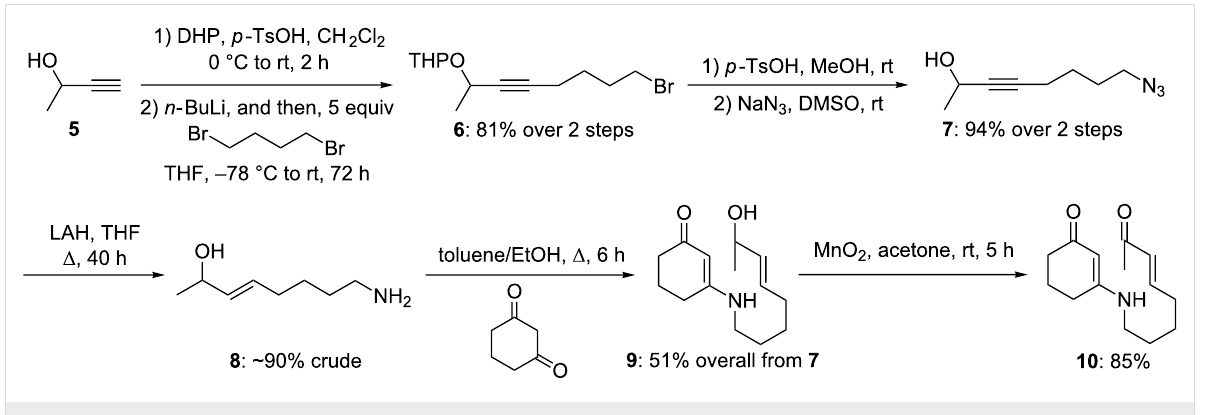
Scheme 2: Synthesis of the annulation precursor enone 10